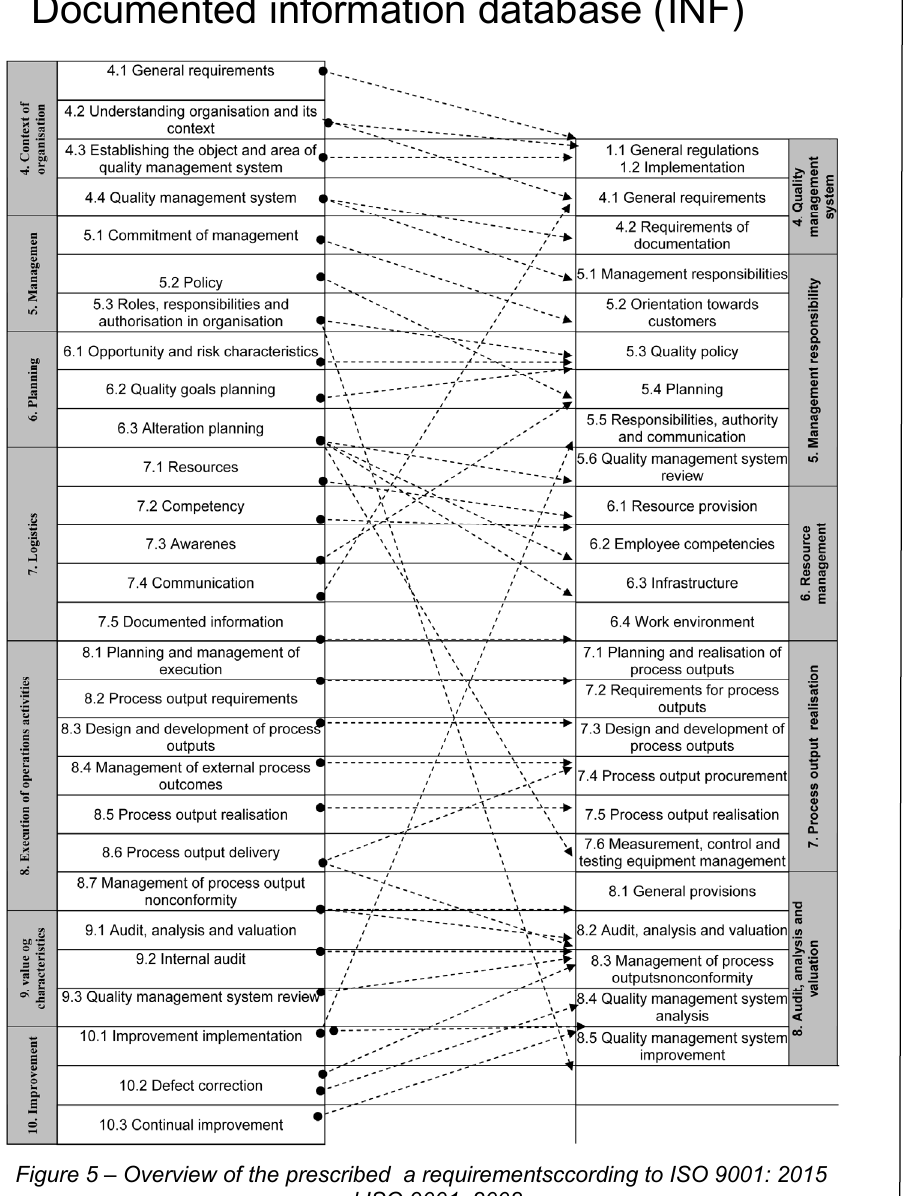
Figure 5 – Overview of the prescribed a requirementsccording to ISO 9001: 2015 and ISO 9001: 2008 Рис . 5 – Обзор установленных требований , в соответствии с ISO 9001: 2015 и ISO 9001: